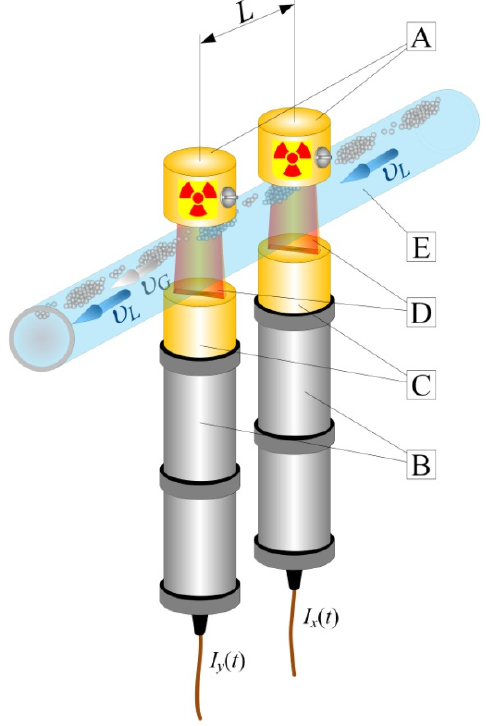
Figure 1. The idea of application of the γ -absorption method to the liquid–gas mixture in a horizontal pipe: A—radioactive source in the collimator; B—scintillation probe; C—detector collimator; D—a gamma-ray beam; E—pipeline; υ G —velocity of the gas; υ L —velocity of the liquid; I x ( t ), I y ( t )—voltage pulses; L —probes distance.